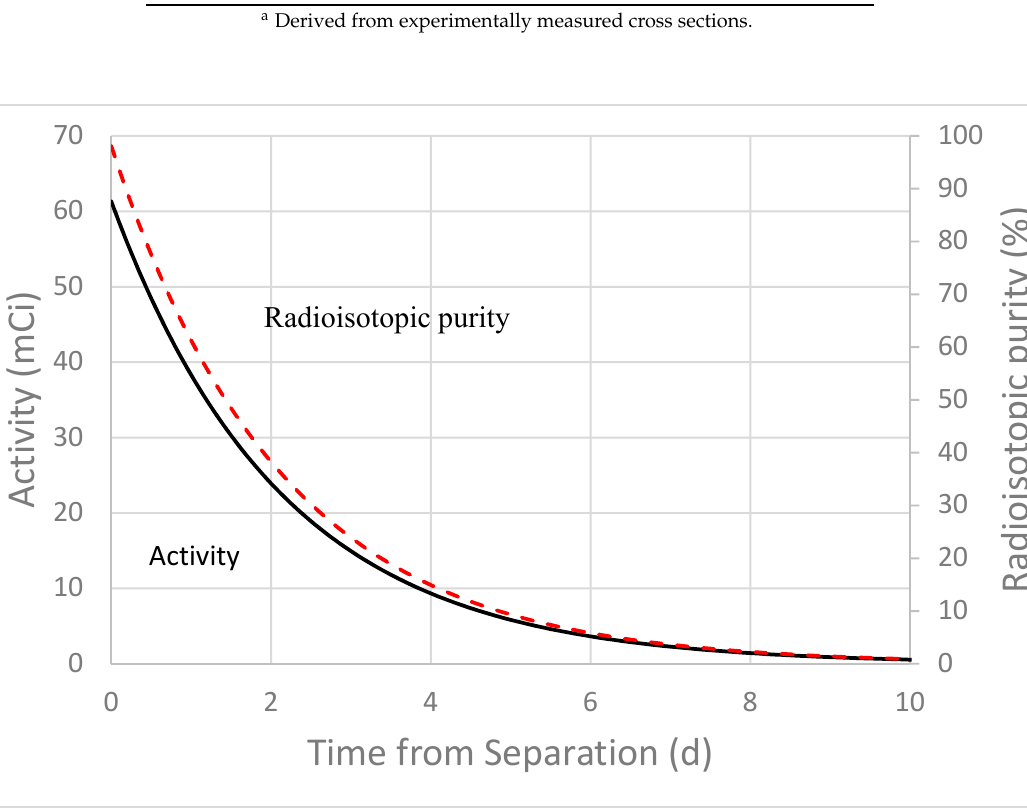
Figure 4. MCNP6 and experimentally calculated radioisotopic purity of Rh-105. Calculations assume rhodium purified from Ac-225 waste streams and irradiation parameters specified in the caption for